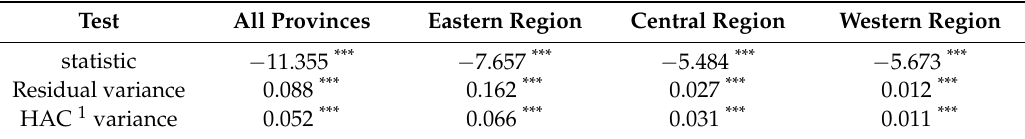
Table A4. Kao test